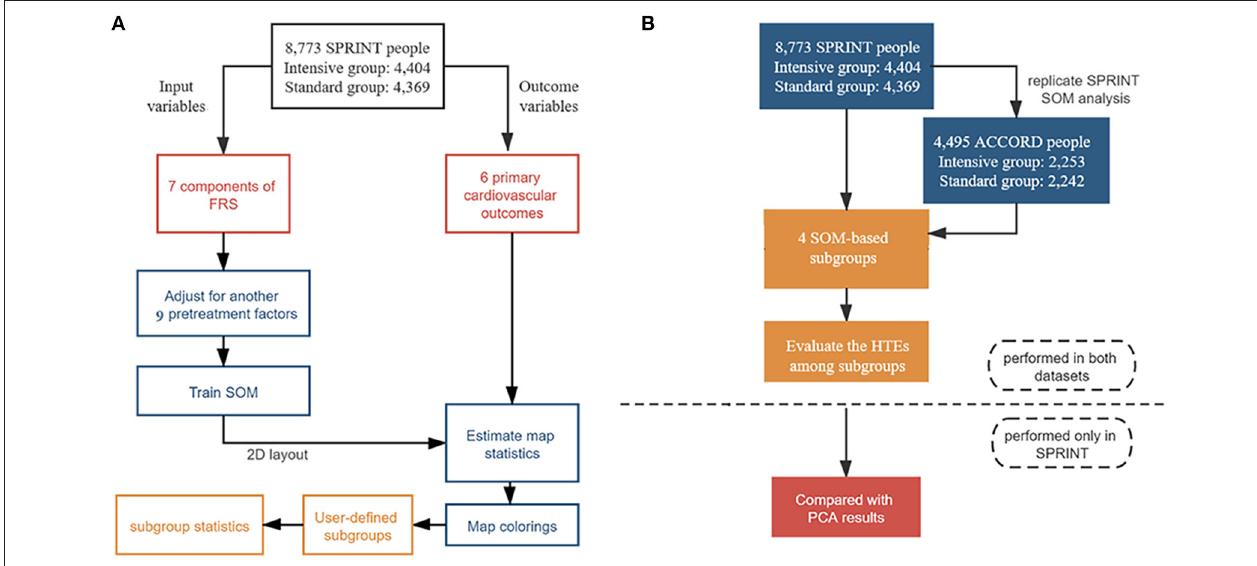
FIGURE 1 | Flowchart of statistical analysis steps. (A) Steps of self-organizing map (SOM) analysis in the Systolic Blood Pressure Intervention Trial (SPRINT) data, including data preprocessing, SOM creating, map statistics estimating, maps coloring, interactive subgroup selection, and interpretation of the results process. (B) Steps of the overall analysis: SOM was trained only in the SPRINT and exploratory study of heterogeneity was conducted both in the SPRINT and ACCORD; further sensitivity analysis was also only performed in the